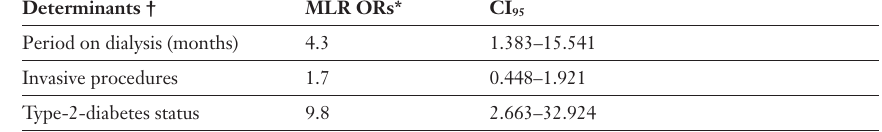
Determinants of the HCV seroconversion by Multivariate analysis